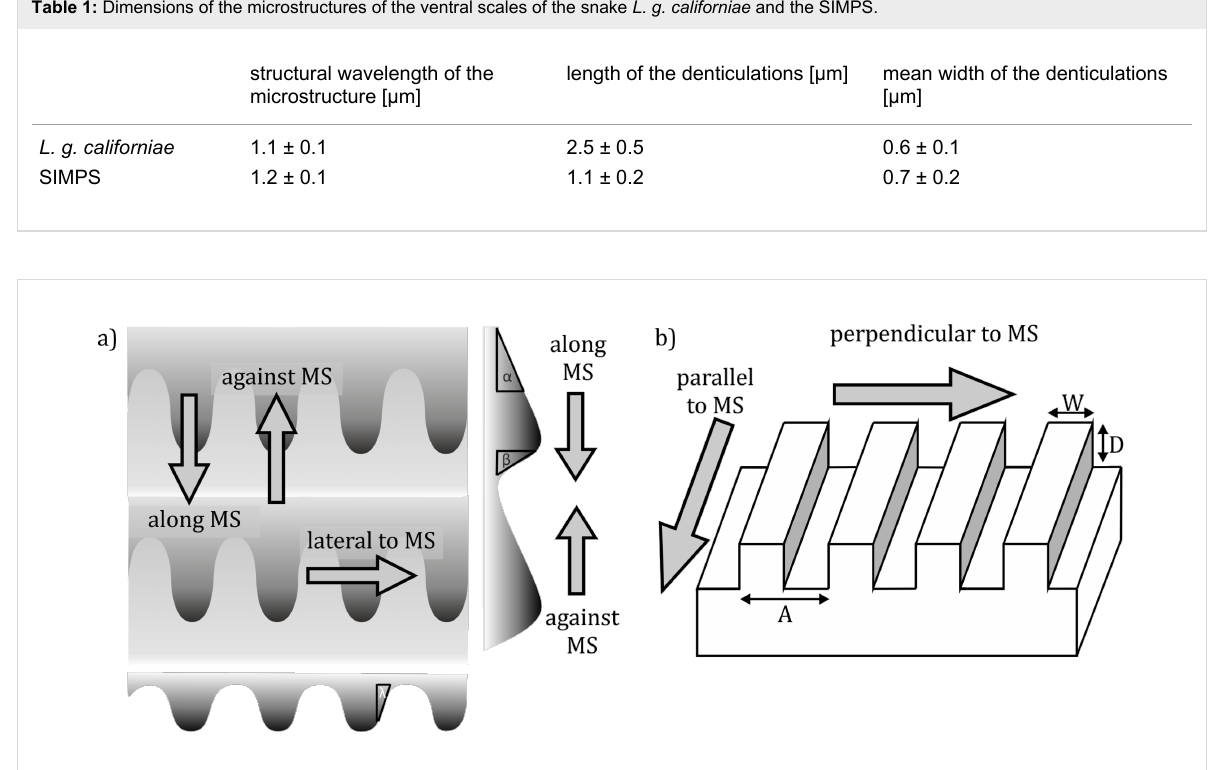
Table 1: Dimensions of the microstructures of the ventral scales of the snake L. g. californiae and the SIMPS.